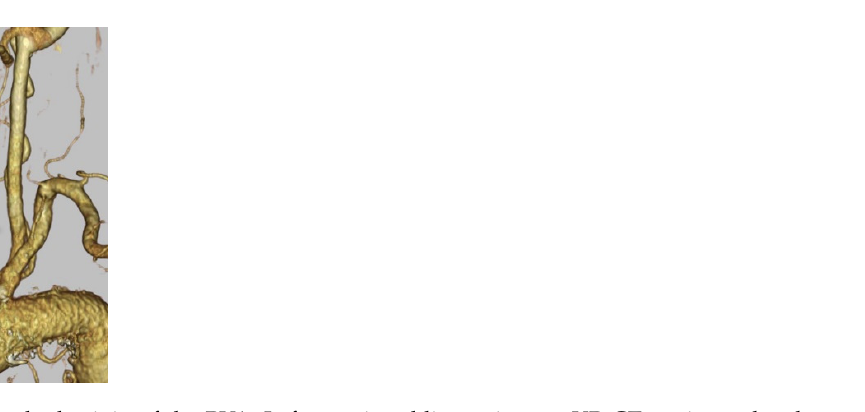
Figure 7. The dual origin of the RVA. Left anterior oblique view on VR-CT angiography shows the dual origin of the RVA. The abnormal VA originates from the RSCA (black arrowhead). The Ziostation 2 (Ziosoft Inc., Tokyo, Japan) was used to obtain the VR image.